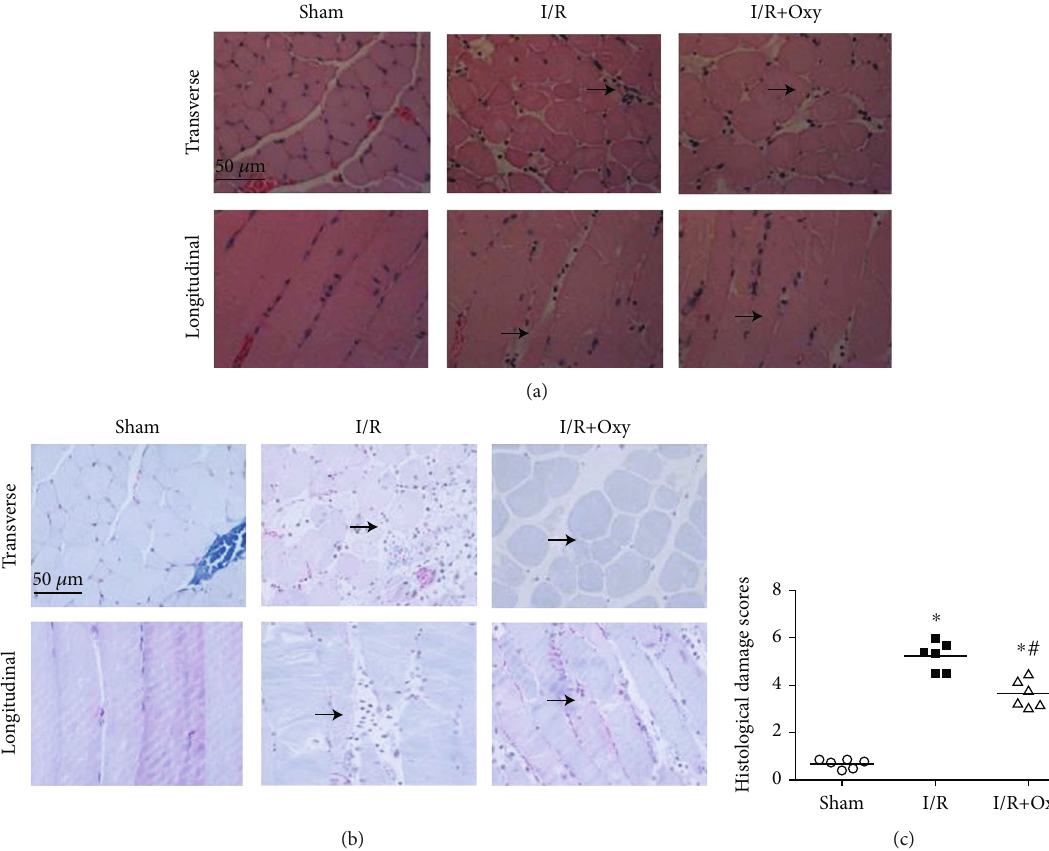
Figure 2: Morphology changes in gastrocnemius muscle tissues in response to tourniquet placement. (a) Representative histology in longitudinal and transverse sections of gastrocnemius muscles stained with hematoxylin-eosin. (b) Representative histology in cross and lengthwise sections of gastrocnemius muscles stained with Masson ’ s trichrome. Arrows indicate the site of muscle injury. (c) Summary data of histology damage scores in sham, I/R, and I/R plus Oxy groups. I/R: ischemia-reperfusion; Oxy: oxycodone ( n = 6 in each group).